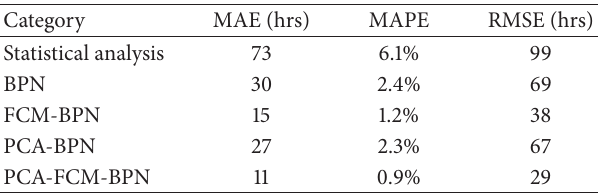
Table 8: Comparison of the forecasting performances.